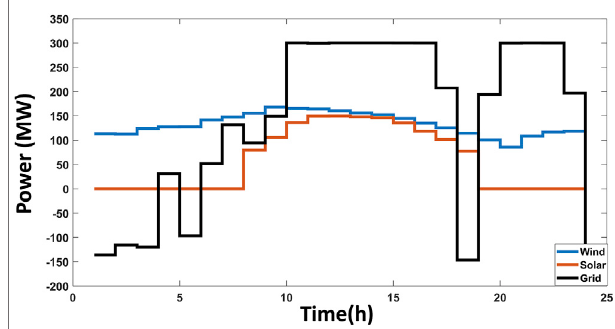
FIGURE 8 | Cost breakdown for the studied optimization techniques (case study 1). FIGURE 9 | Optimal output power for solar, wind and grid power transaction (case study 2) obtained by the studied optimization techniques.